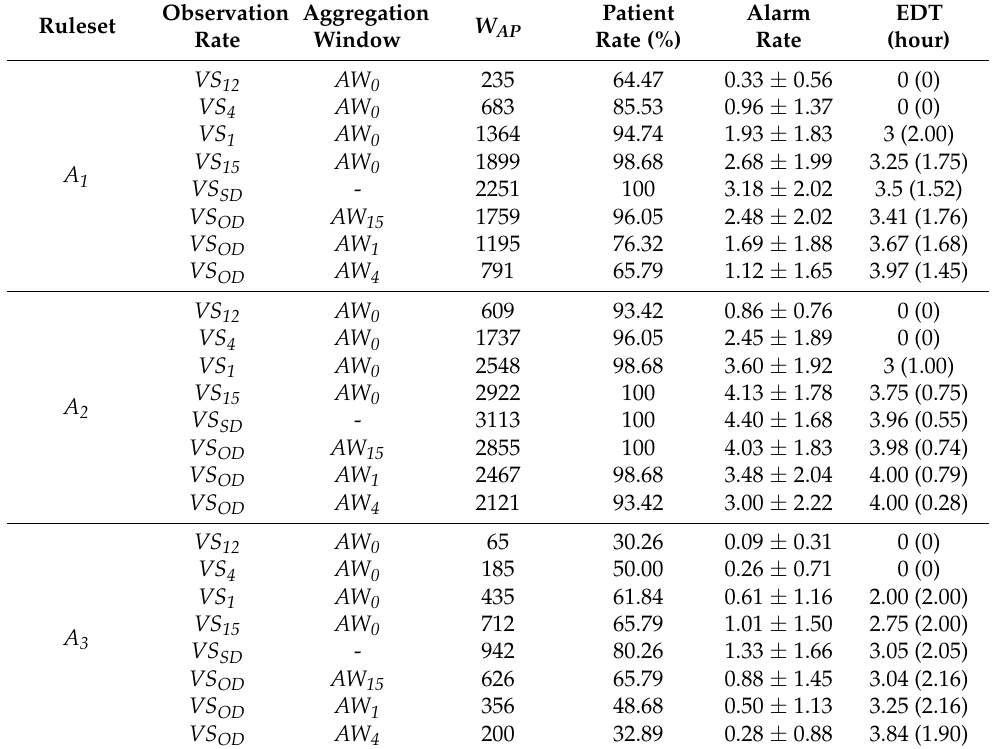
Table 2. Alarm metrics.